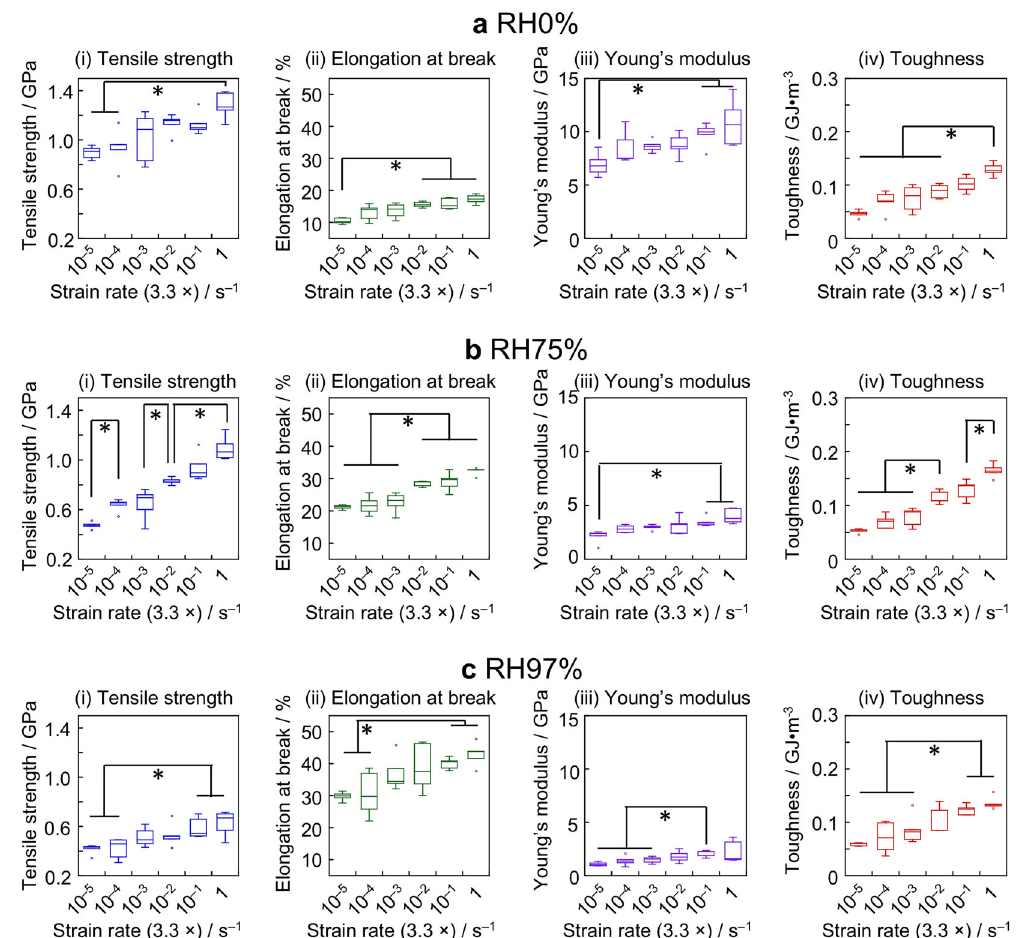
Fig. 7 Humidity effects on mechanical properties of spider dragline silk fi bers. Mechanical properties of dragline silk fi bers at a RH0%, b RH75%, and c RH97% under strain rates ranging from 3.3 × 10 − 5 to 3.3 s − 1 : (i) tensile strength, (ii) elongation at break, (iii) Young ’ s modulus, and (iv) toughness. *Signi fi cant differences between groups at p <